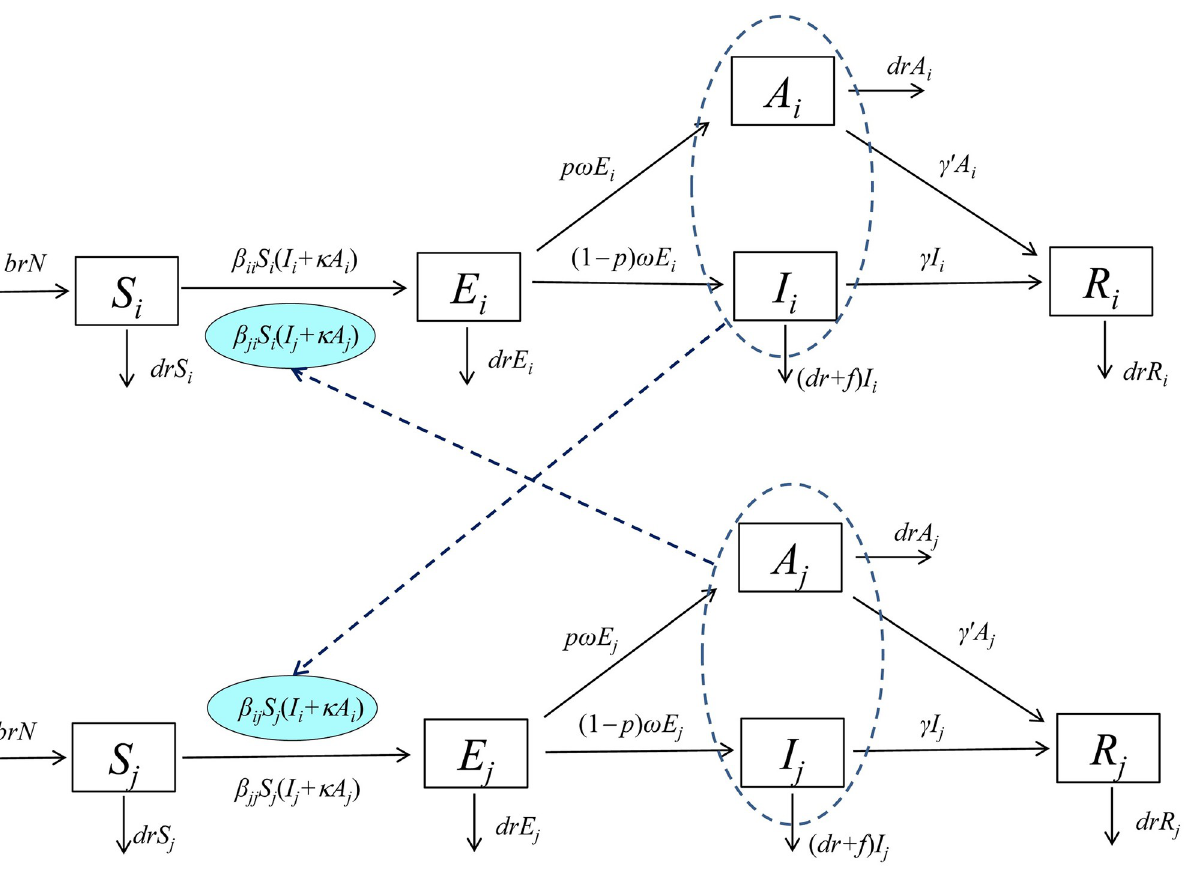
Fig 2. Flowchart of age-specific SEIAR model of shigellosis. i 6¼ j ; i and j represent age group � 5 years old, 6–24 years old, 25–59 years old, and � 60 years old, respectively.